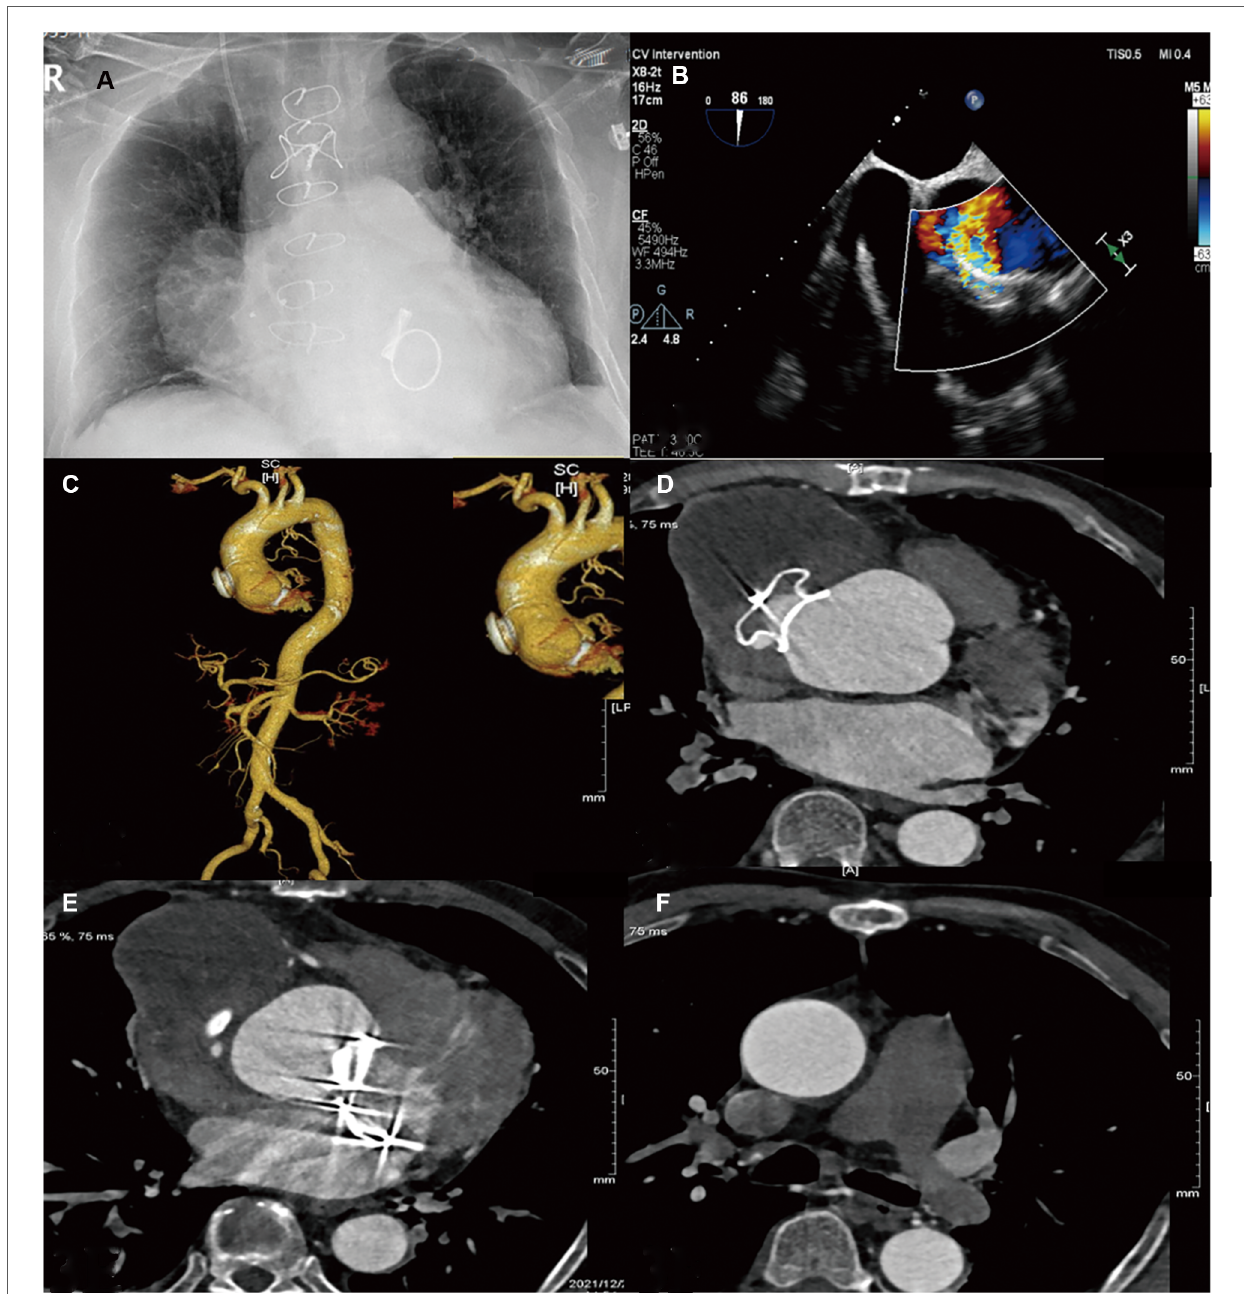
FIGURE 3 Preoperative: ( A ) Chest ray; ( B ) Cardiac ultrasound; ( C – F ) CT of the coronary artery+thoracic and abdominal aorta [( C ) Front position; ( D ) Tumor waist; ( E ) Lower border of the tumor; ( F ) Pulmonary